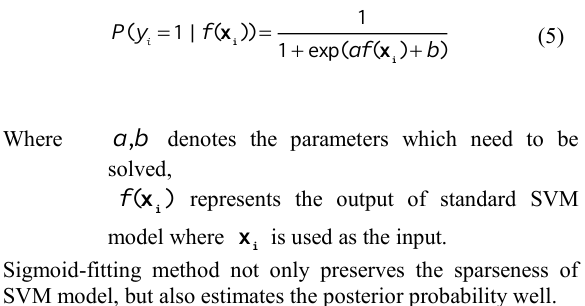
Figure 7 Hyperplane optimization based on the optimal sample